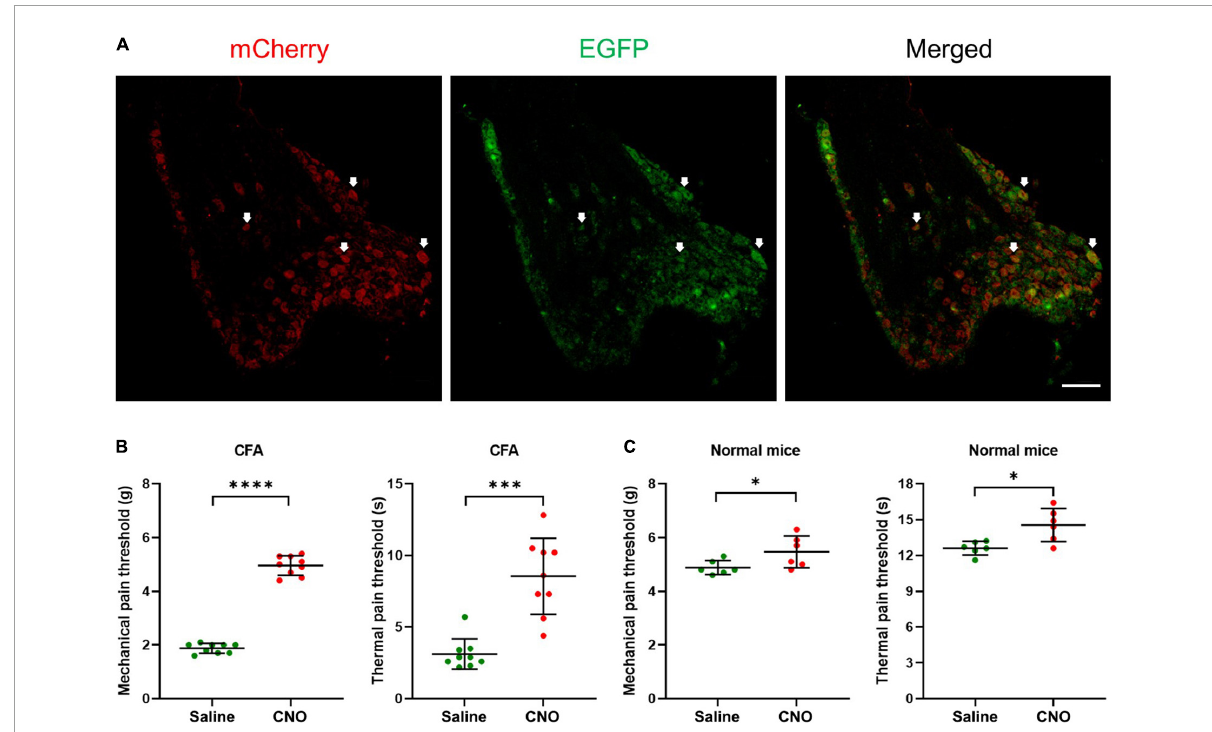
FIGURE3 Inhibition of shared neurons induced analgesia in CFA mice. (A) The representative pictures of DRG neurons expressing hM4D(Gi) receptors. The white arrows indicate double-labeled DRG neurons. As the EGFP signals were from original EGFP proteins expressed by the AAVRetro-hSyn-Cre-EGFP virus, while the mCherry proteins were expressed in a cre-dependent manner and their signals were amplified by the mCherry antibodies, all mCherry signal positive neurons were shared neurons. Bar = 150 µ m. (B) The mechanical pain thresholds and thermal pain thresholds of the ipsilateral hind paw plantar were elevated after CNO treatment in the CFA model. n = 9, paired t -test. For mechanical pain thresholds, ∗∗∗∗ P < 0.0001. For thermal pain thresholds, ∗∗∗ P = 0.0004. (C) The mechanical pain thresholds and thermal pain thresholds of the ipsilateral hind paw plantar were increased a little after CNO treatment in normal mice. n = 6, paired t -test. For mechanical pain thresholds, ∗ P = 0.0472. For thermal pain thresholds, ∗ P = 0.0122.